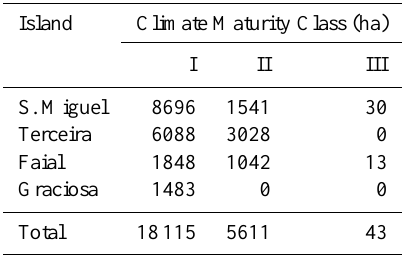
Table 4. Areas (ha) with potential for grapevine production for each island and climate maturity